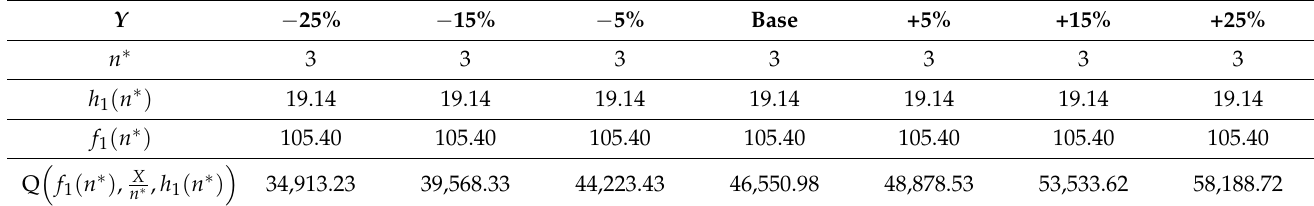
Table 13. Variation of the length of the service area Y